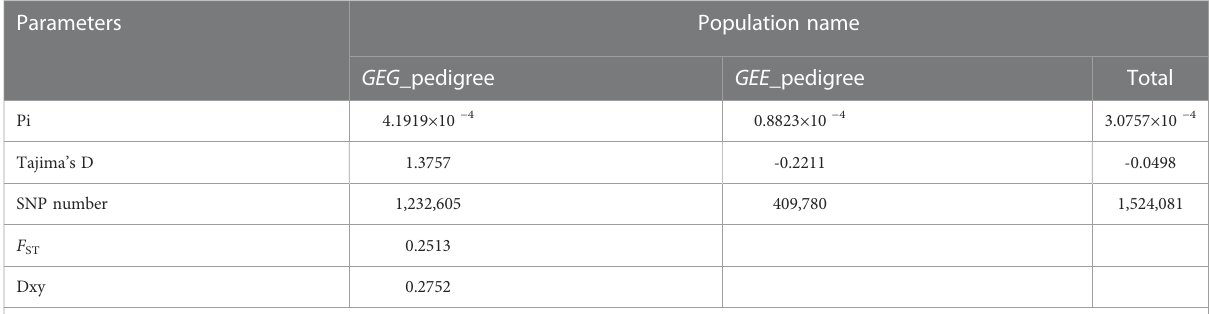
TABLE 3 Genetic diversity and genetic differentiation of different populations.